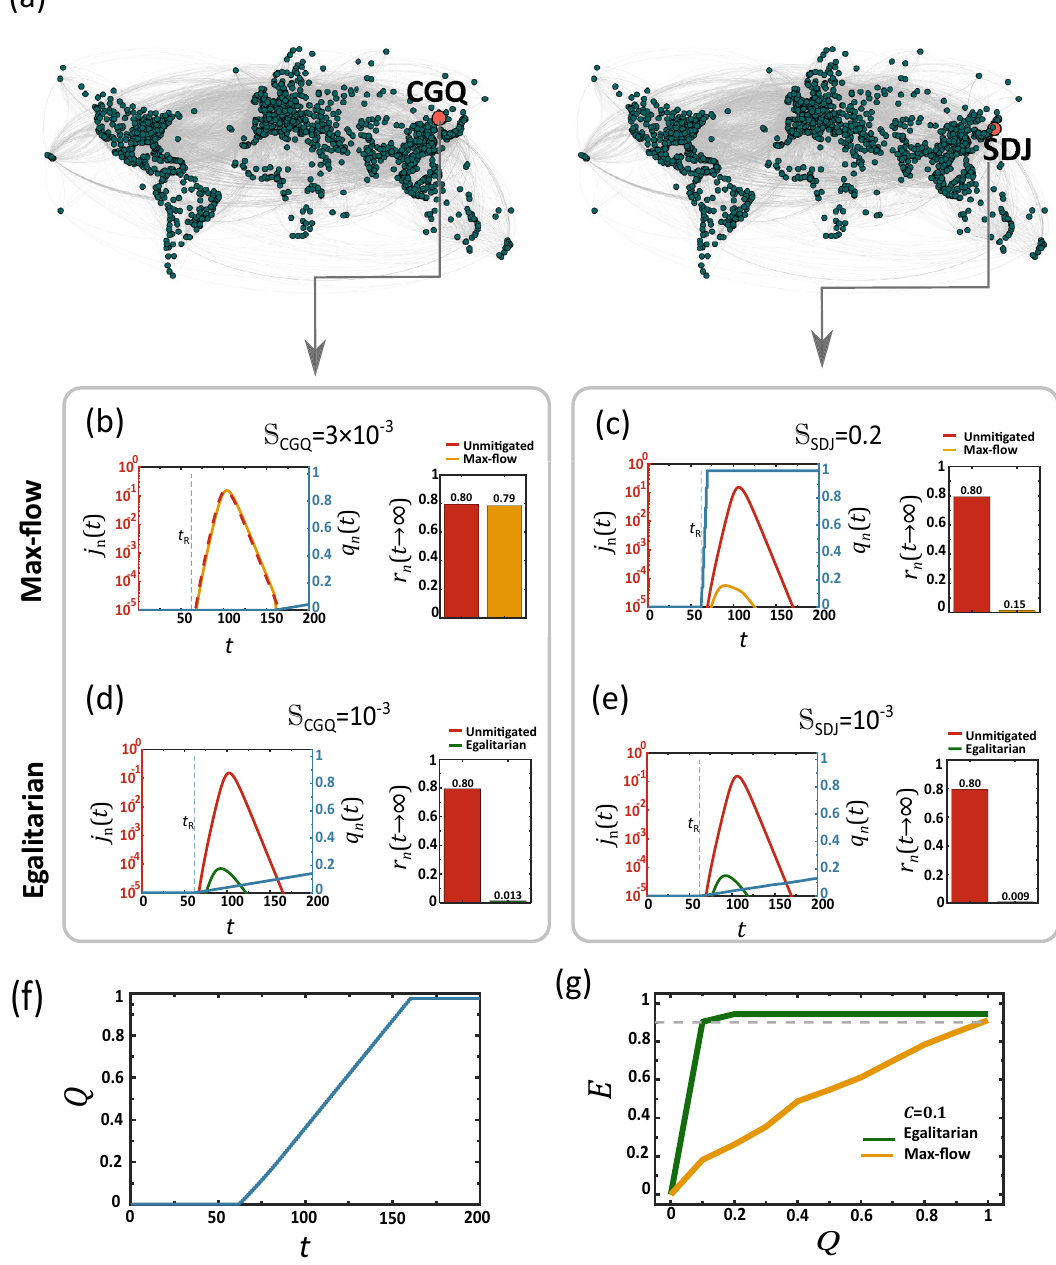
Figure 4. The roots of the egalitarian advantage. ( a ) We focus on two specific nodes, SDJ (right), who, under max-flow, is among the S S − 3 early supplied nodes ( ). CGQ = 3 × 10 SDJ = 0.2 ), and CGQ (left), representing the majority of undersupplied destinations ( ( b ) Therapeutic availability q n ( t ) vs. t at CGQ (blue) as obtained under max-flow dissemination. Due to the sequential nature of this dissemination scheme, the therapeutic reaches CGQ too late, and consequently its infection level j n ( t ) remains high, both without (red) and under the effect of max-flow mitigation (yellow). ( c ) In contrast, SDJ is among the first to fill its demand, hence the sharp rise in q n ( t ) at an early stage (blue). As a result this node benefits from highly efficienct mitigation, with r n ( t → ∞ ) reduced dramatically from 80% (unmitigated, red) to a mere 15% (mitigated, yellow). The challenge is that while CGQ is representative of the majority of destinations, the highly benefited SDJ belongs to a highly exclusive minority and hence cannot represent the typical mitigation efficiency. ( d , e ) Egalitarian generates a homogeneous supply pattern, hence now both CGQ and SDJ share a similar (low) − 3 . Still, they both benefit from a near perfect mitigation (unmitigated—red; mitigated – green). This is thanks to supply rate of ∼ 10 the fact that despite their equal but slow supply, they now both begin to receive the therapeutic at an early stage ( q n ( t ) , blue). Indeed, − 3 even SDJ, who is now, under egalitarian, experiencing a dramtic drop in its supply rate, from 0.2 to 10 , continues to benefit from highly efficient mitigation. Hence, the simulataneous, albeit uniformly slow, treatment afforded via egalitarian, not only benefits the max-flow deprived majority, but also continues to effectively treat the superflous minority. ( f ) The global consumption Q ( t ) vs. t , approaching unity, i.e. all demands are filled, when t → ∞ . ( g ) Global mitigation efficiency E vs. the volume of disseminated therapeutics Q . Under max-flow we have E → 1 only in the limit Q → 1 (yellow), i.e. supplying the entire global demand. In contrast, egalitarian has E ∼ 1 already at Q ∼ 0.1 , achieving, thanks to its concurrent supply patterns, an almost perfect mitigation with only 10% of the